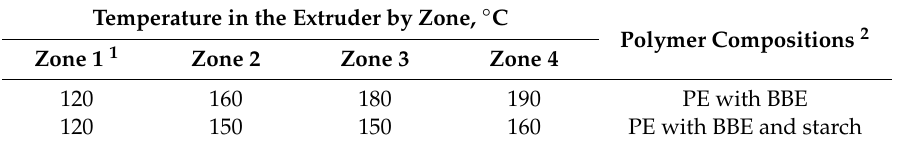
Table 2. Temperature conditions for the processing of the polyethylene compositions in the extruder.